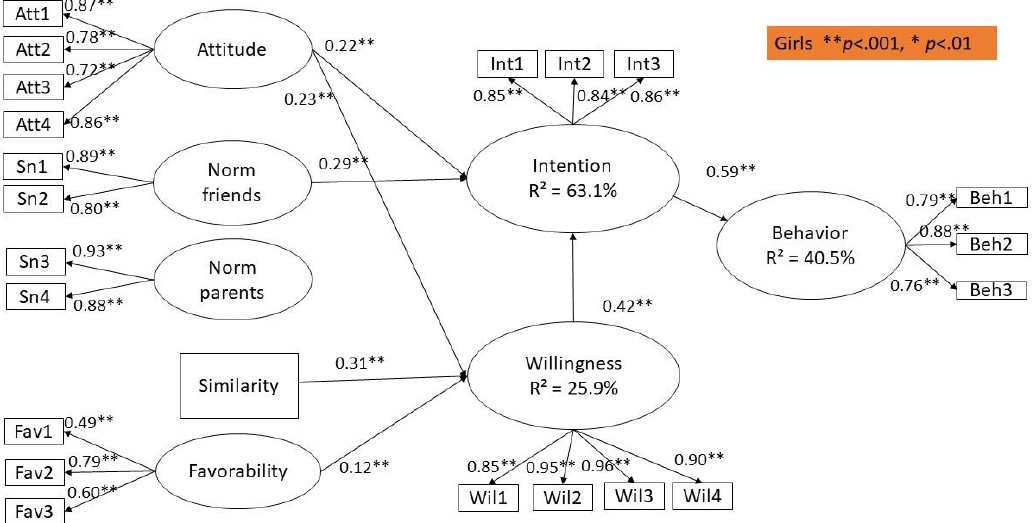
Figure 2. Structural model for boys. ** p < 0.001, * p < 0.01